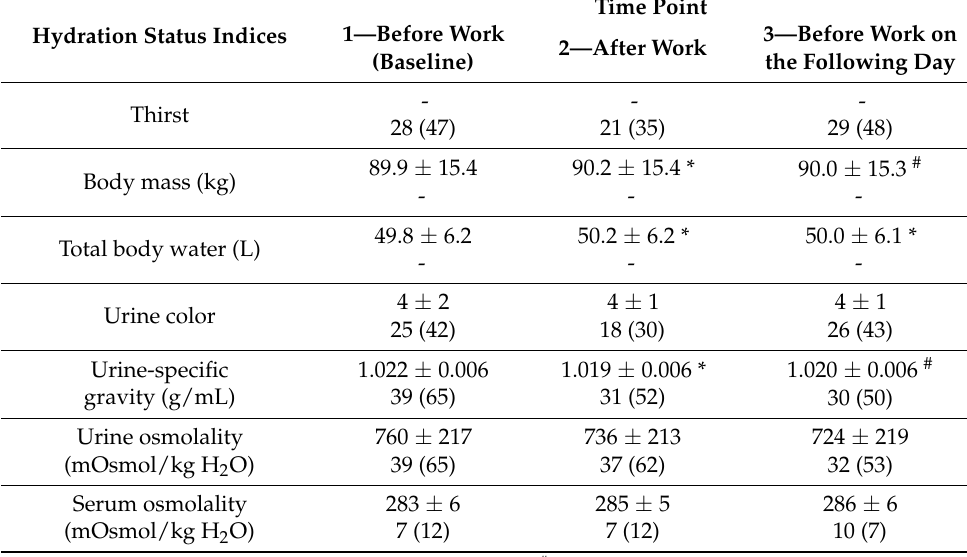
Table 3. The results of the assessment of hydration status indices at time points: mean ± standard deviation and the number (percentage) of dehydrated workers (where